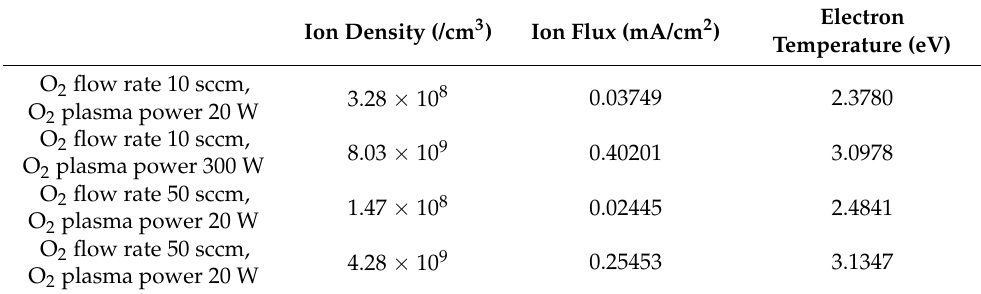
Figure 2. Surface roughness of the HfO 2 films deposited at different flow rates and plasma power of O 2 : ( a ) 10 sccm and 20 W, ( b ) 10 sccm and 300 W, ( c ) 50 sccm and 20 W, and ( d ) 50 sccm and 300 W. ( e ) Comparisons of surface roughness of HfO 2 films in our work and those reported by other research groups [9,36–40]. Table 1. Plasma properties measured at the center of the